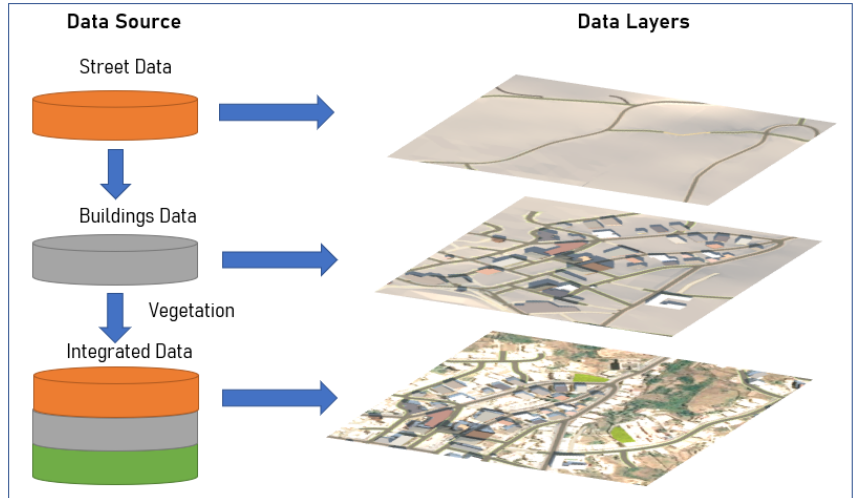
Figure 1. GIS data source and